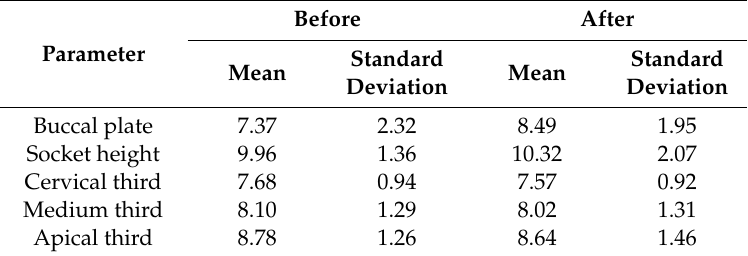
Table 2. Means and standard deviations (in mm) of the evaluated parameters in the TG2, before, and four months after, the procedure (particulate bovine bone and d-PTFE membrane for socket preservation), based on CT analysis. Before